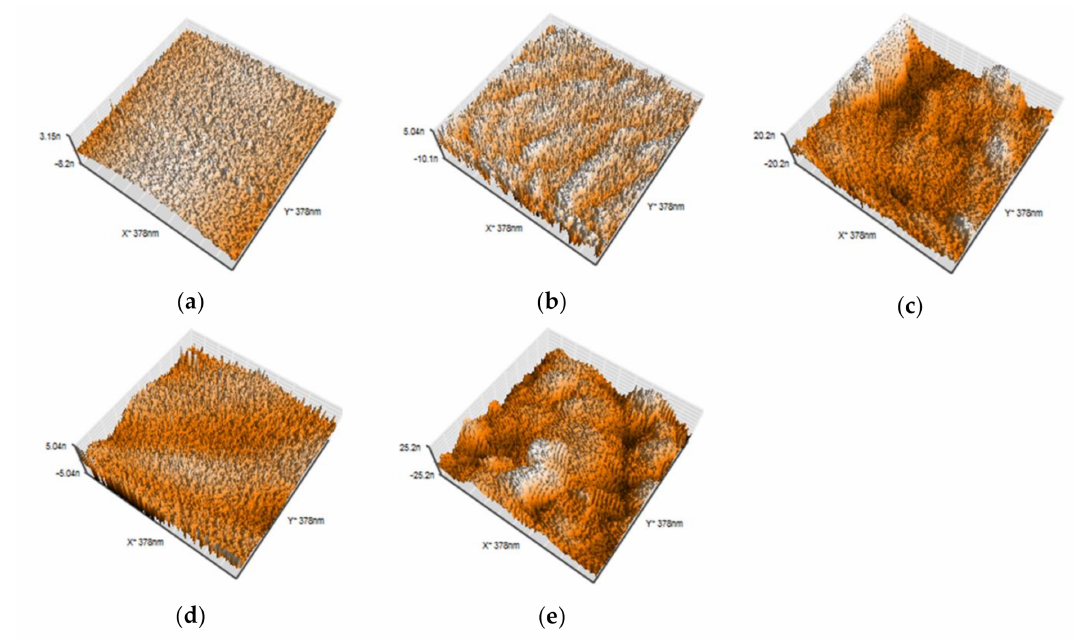
Figure 5. Three-dimensional AFM images: ( a ) Control; ( b ) Ar; ( c ) Ar / F; ( d ) Ar + Ag; ( e ) Ar / F + Ag specimens. Table 4. Surface roughness.